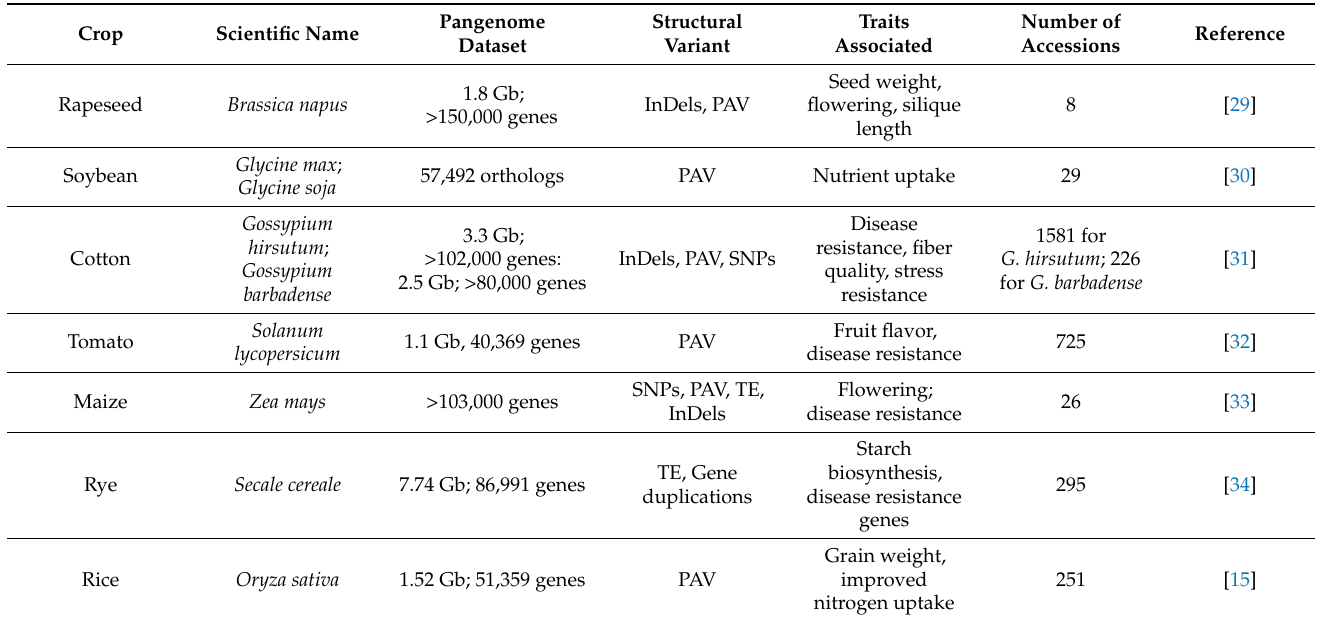
Table 1. Trait-associated factors residing on dispensable genomes identified through